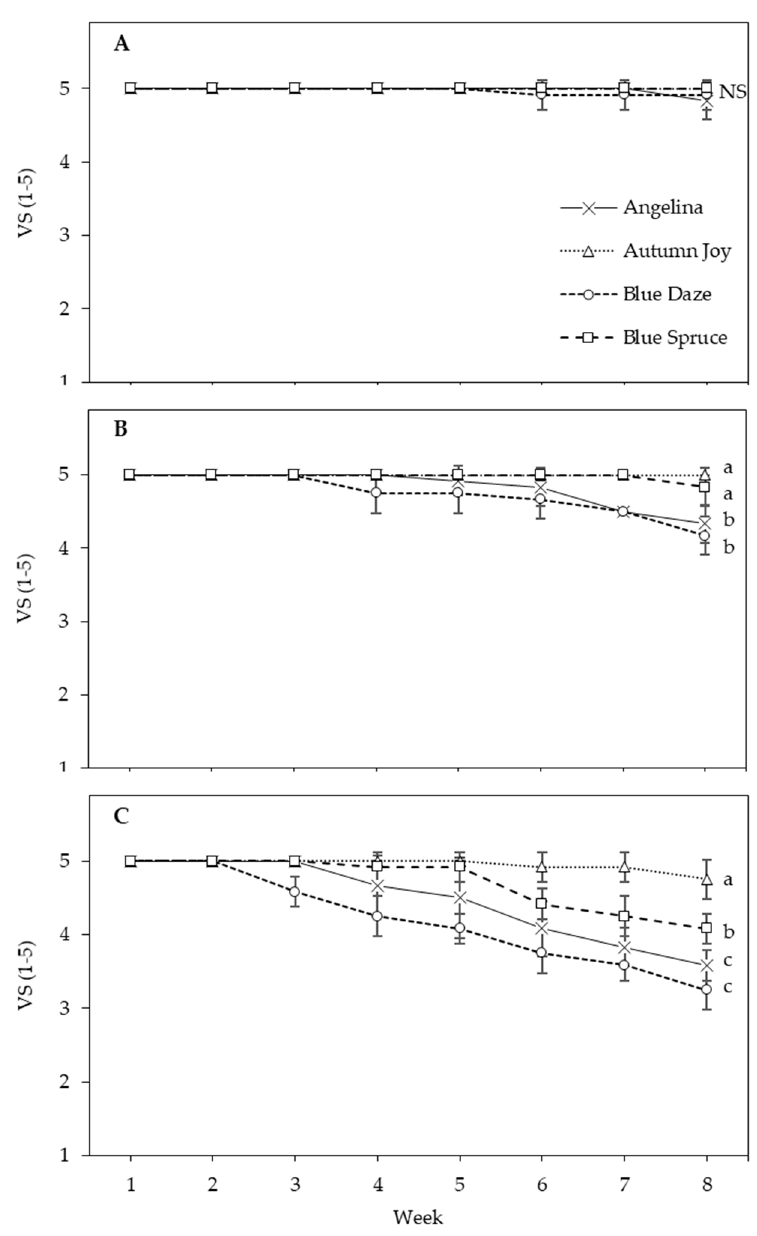
Figure 3. Mean visual score of foliar salt damage of four perennial ornamentals irrigated with control ( A ), EC5 ( B ), and EC10 ( C ) treatments for eight weeks. The visual score was based on a scale of 1–5, where 1 = severe leaf burn and defoliation; 2 = moderately-severe leaf burn and defoliation; 3 = moderate leaf burn; 4 = minimal leaf burn; 5 = no leaf burn. Letters indicate significant differences among varieties for the final week according to Tukey’s HSD test ( p < 0.05). Bars represent standard deviation.